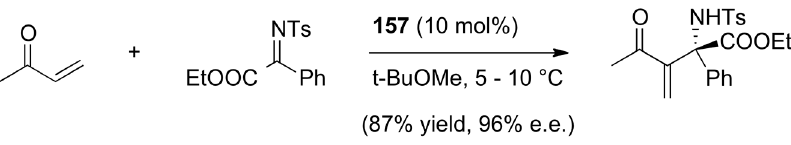
Scheme 62. An enantioselective aza ‐ Morita–Baylis–Hillman reaction.